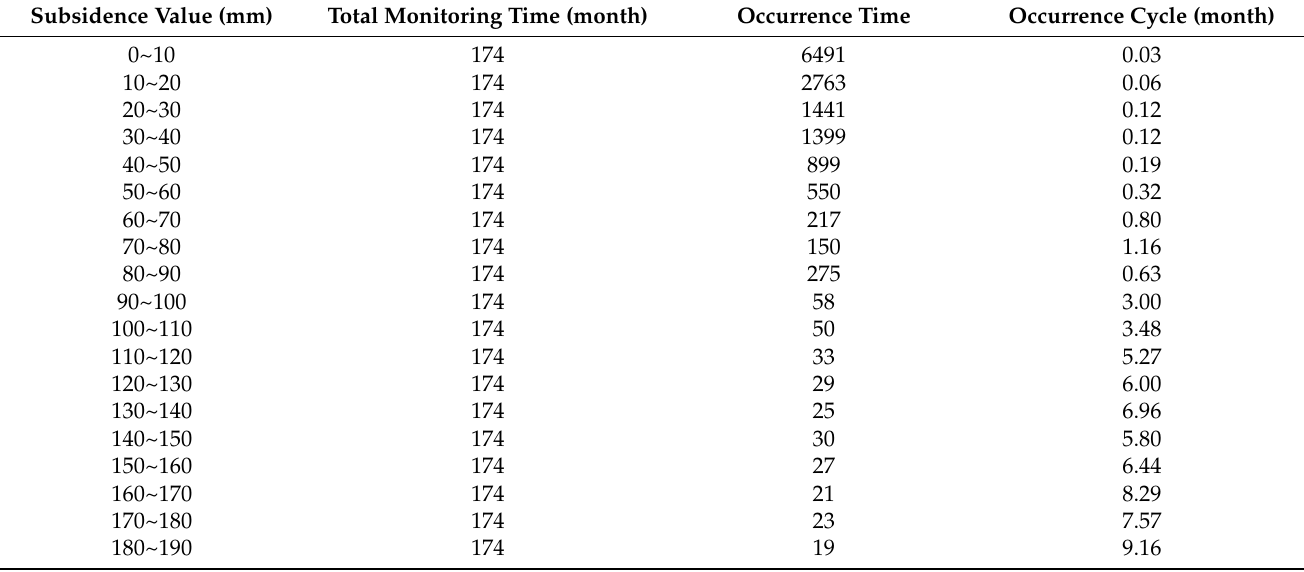
Table 1. Subsidence occurrence cycle of 500 monitoring